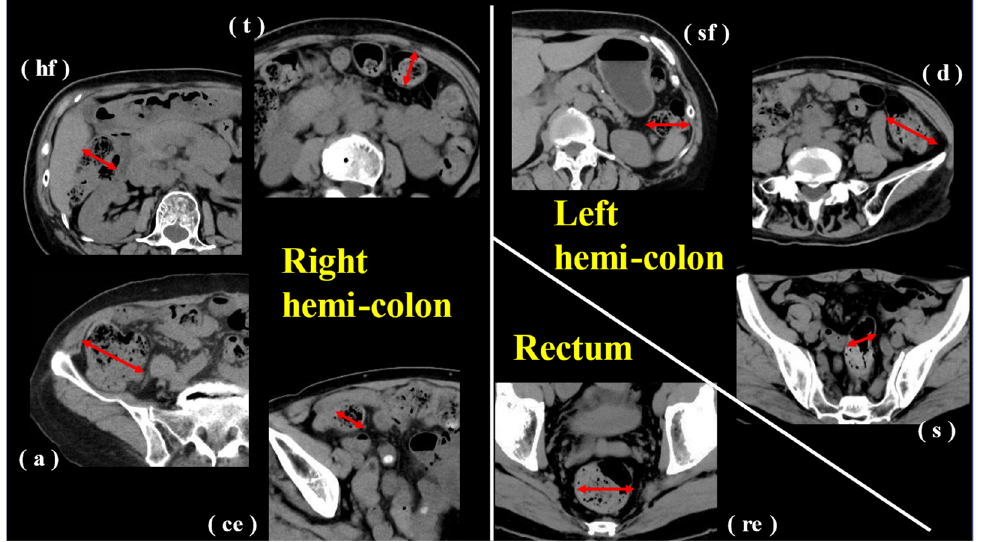
Figure 1. Simple CT image (axial image) of the abdomen and pelvis at each site of right hemi-colon, left hemi-colon and rectum. Diameter was measured at the most dilated site of the intestine (red line). ( ce ), cecum; ( a ), ascending colon; ( hf ), hepatic flexure; ( t ), transverse colon; ( sf ), splenic flexure; ( d ), descending colon; ( s ), sigmoid colon; ( re ), rectum.